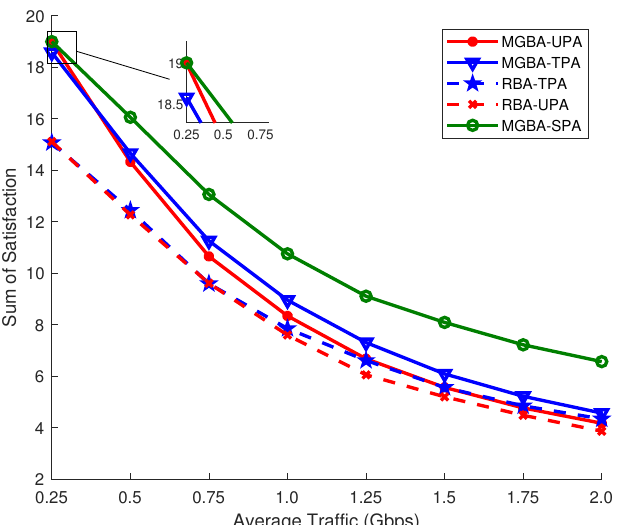
Figure 5. The sum of satisfaction performance comparison against different average traffic requests of LBCs.